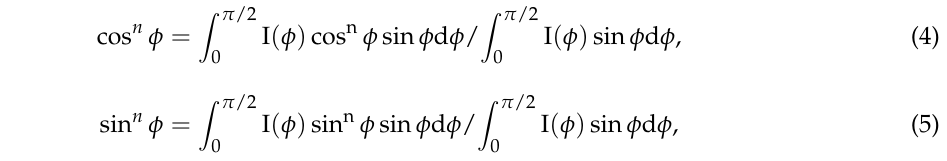
Figure 1. Skin–core structure model of carbon fiber.